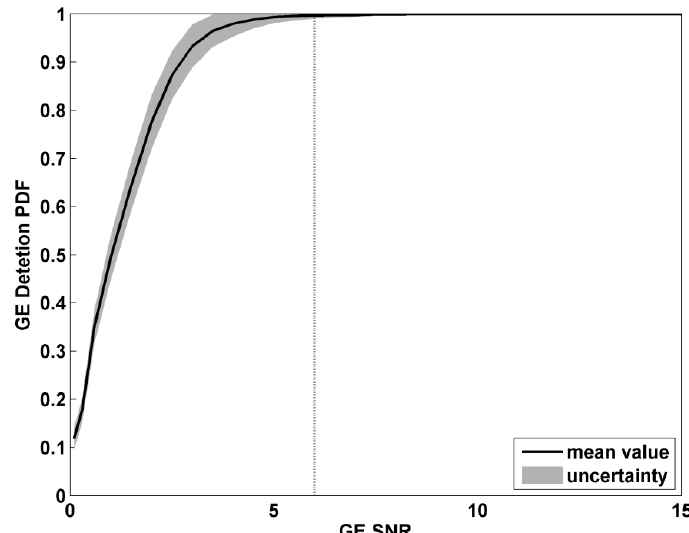
Figure 9. The probability density functions (PDF) of the good detection of the ground echo (GE) vs. SNR at the ground level (GE SNR). The optimal SNR of 6 is highlighted by the black vertical dotted line.